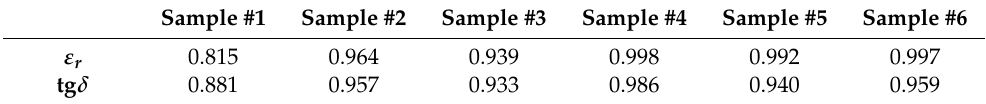
Table 5. Pearson’s coefficient from measurements for light and strong pressure on substrate samples.